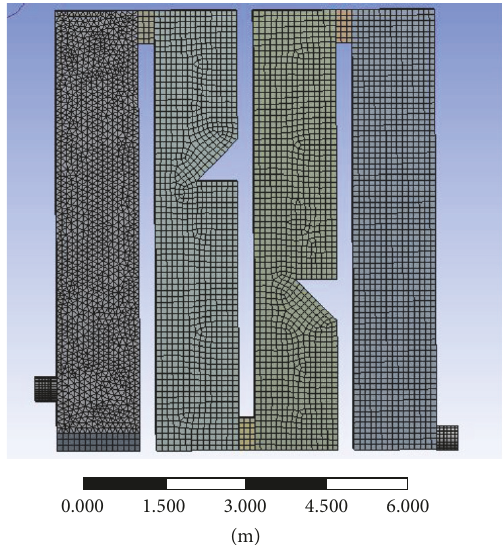
Figure 7: Mesh modeling of final decay tank model.